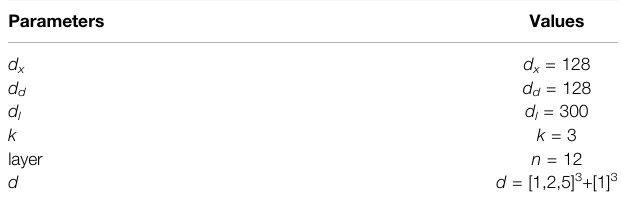
TABLE 4 | RD-GCNN.